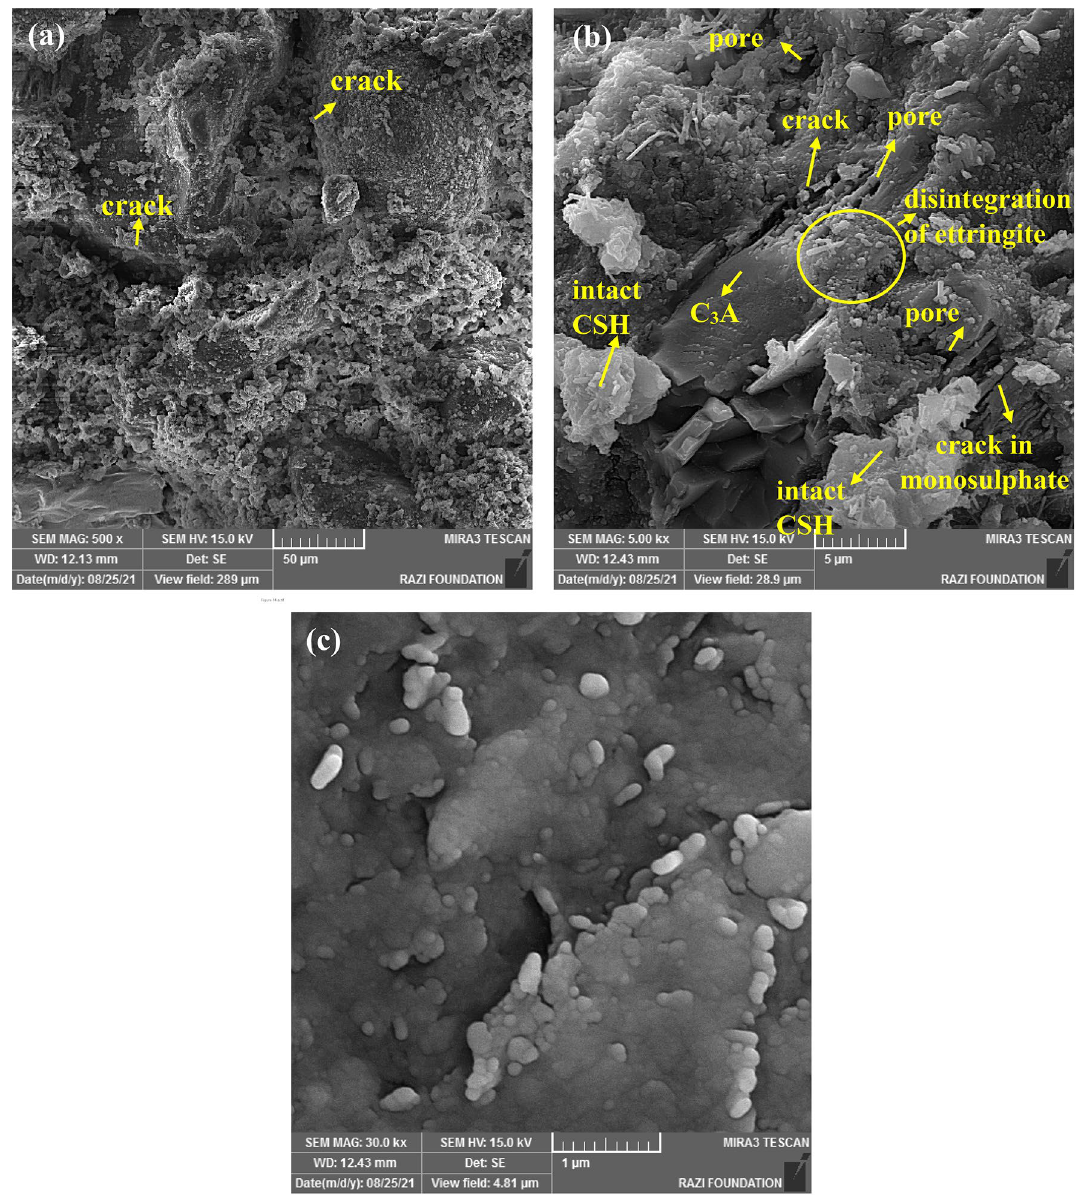
Fig. 14 The scanning electron microscope (SEM) images of mixture with 10% cement subjected to the 6th F-T cycle: a 500× magnification, b 5000× magnification, c 30,000×